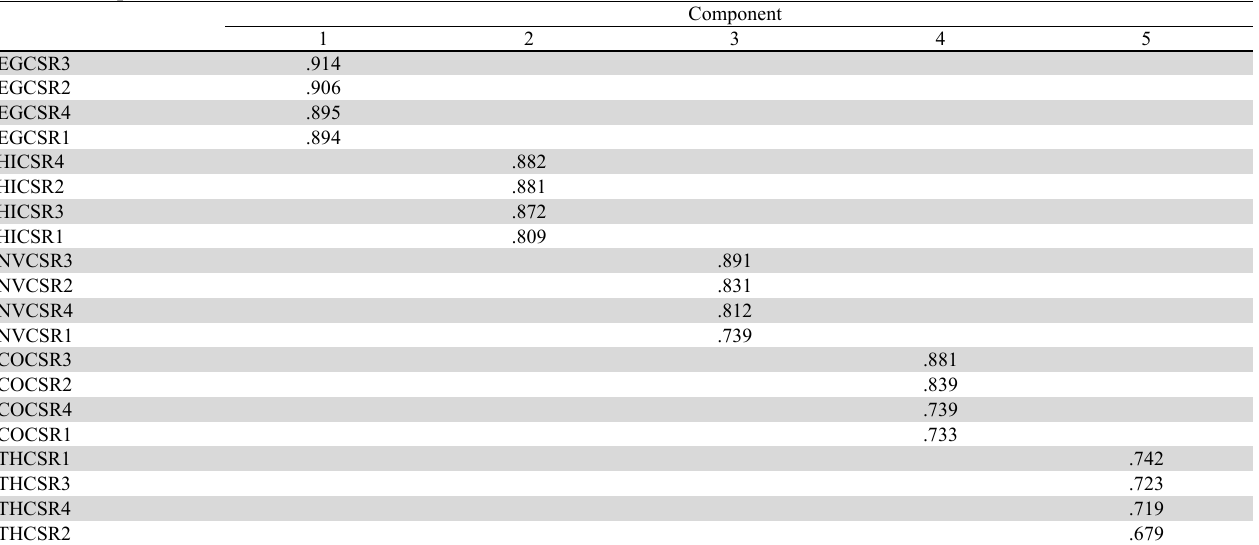
Rotated Component Matrix